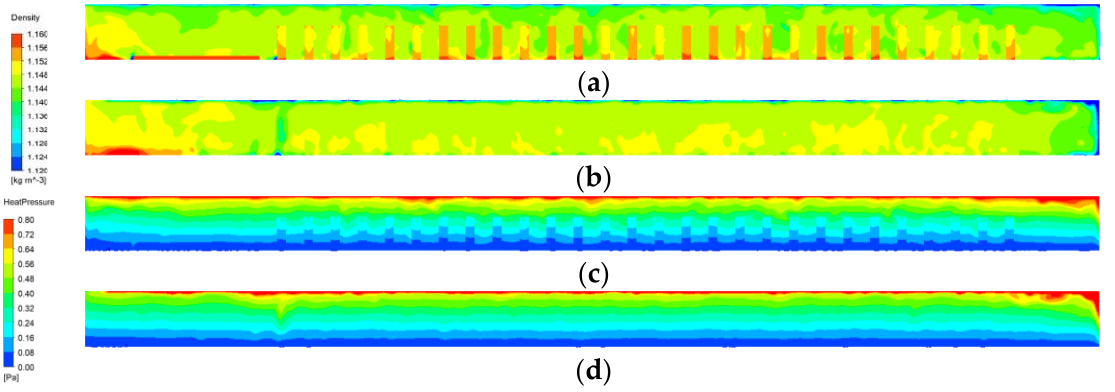
Figure 11. Thermal pressure ventilation characteristics in the high − altitude area of: ( a ) x = 4000 mm, density; ( b ) x = 600 mm, density; ( c ) x = 4000 mm, heat pressure; ( d ) x = 600 mm, heat pressure.